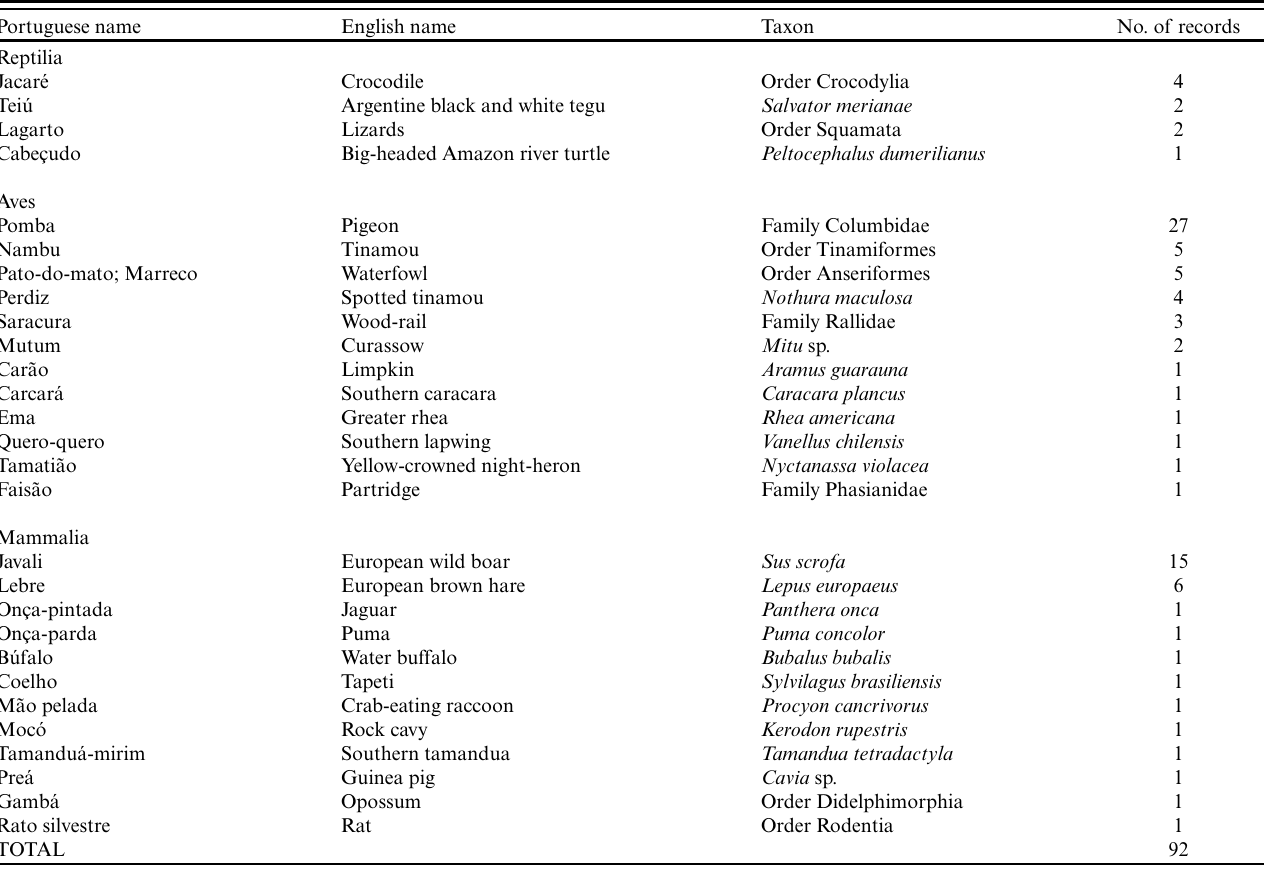
Table 3 . Number of records for each additional taxon (species not included in the search keys) detected on videos of hunting events on YouTube™.